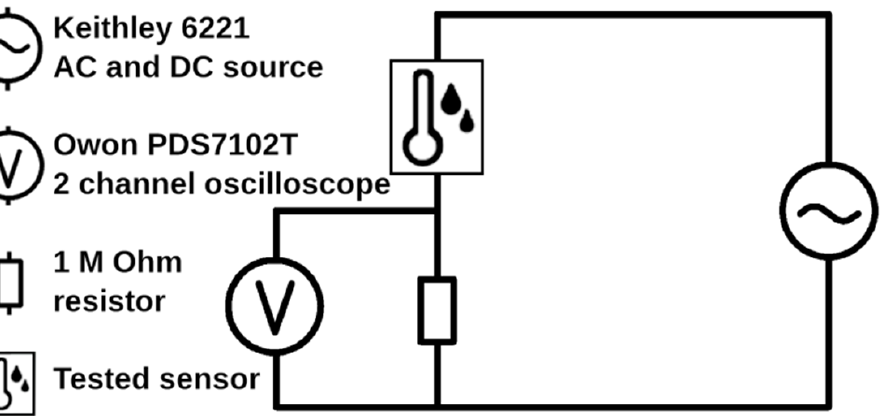
Figure 2. An equivalent scheme (high-pass filter) as was used to measure the change in the capacitance of the prepared micro-structures with varying humidity.